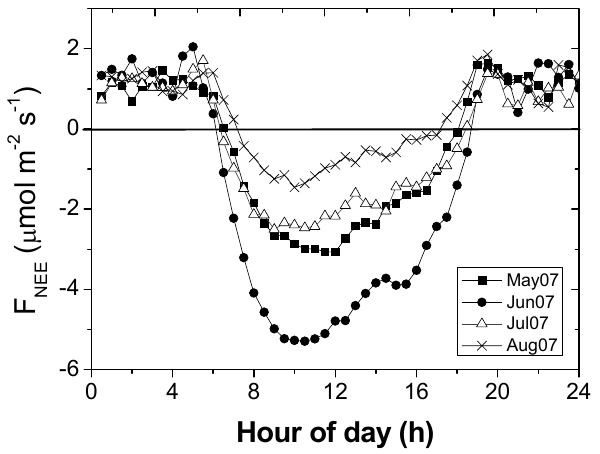
Fig. 4a. Mean diurnal NEE flux during May, June, July and Au- Figure 4a. Mean diurnal NEE flux during May, June, July and August 2007 in the gust 2007 in the alpine Mediterranean shrubland located in Sierra alpine Mediterranean shrubland located in Sierra Nevada mountain range. Nevada mountain range.